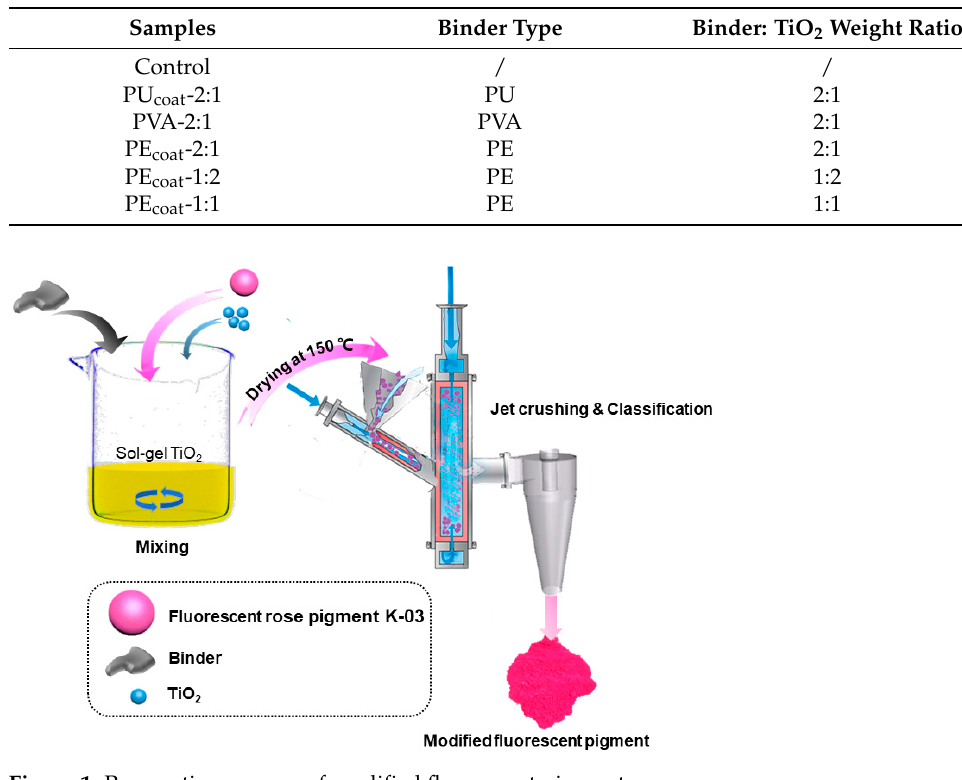
Figure 1. Preparation process of modified fluorescent pigment.